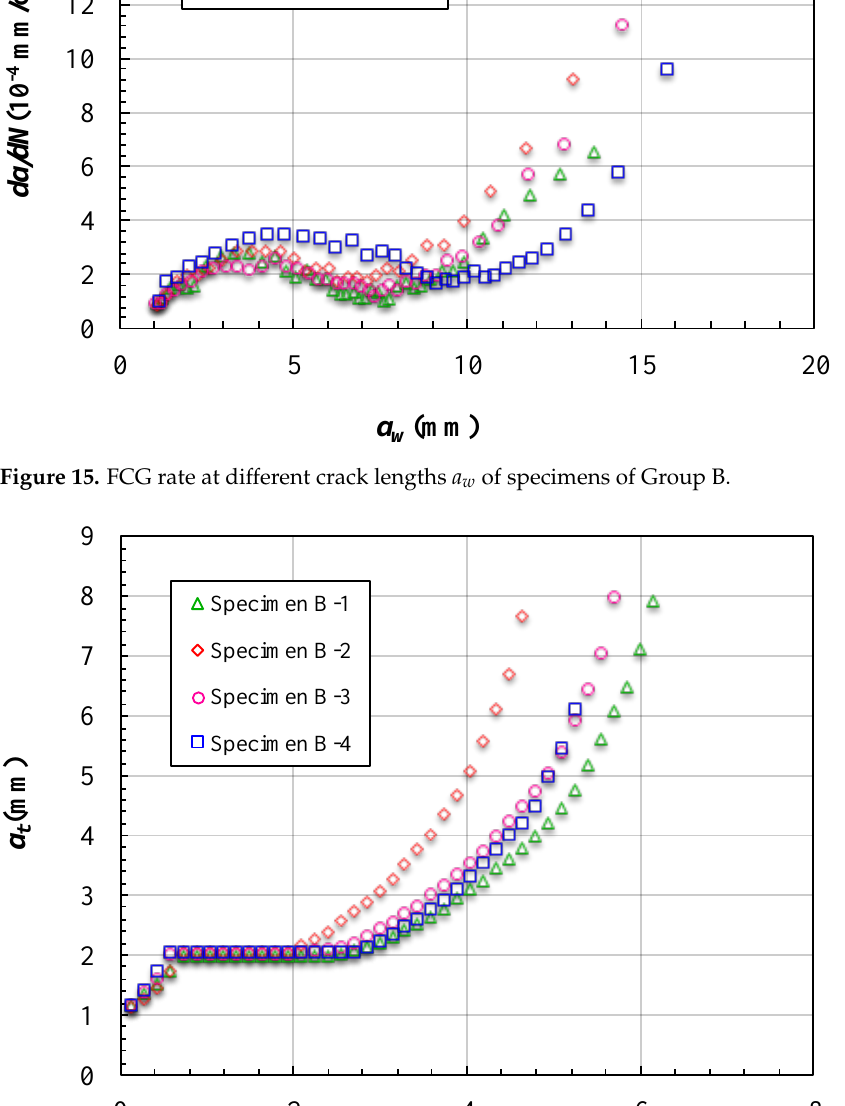
Figure 16. Crack length a t vs loading cycles N of specimens of Group B.